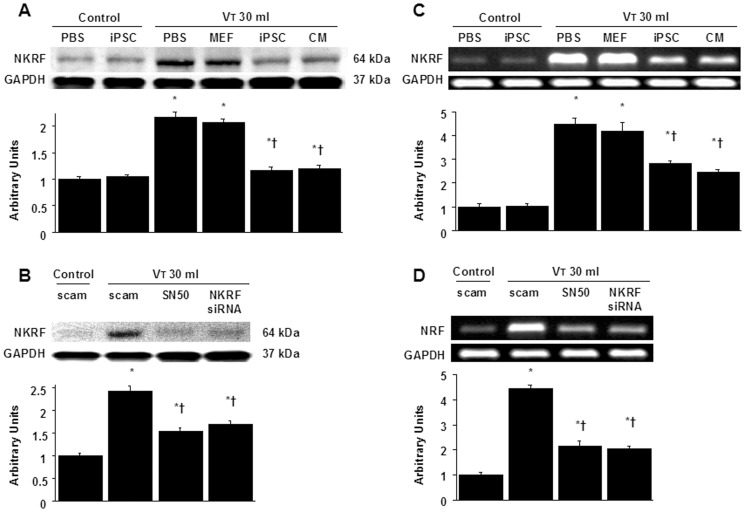
iPSCs or iPSC-CM, SN50, or NKRF siRNA abrogated lung stretch-induced NKRF and NKRF mRNA expression.NKRF expression from the lungs of VT30-ventilated wild-type mice receiving iPSCs, iPSC-CM, SN50, or NKRF siRNA was detected by Western blot analyses (A, B). The effects of administering of iPSCs, iPSC-CM, SN50, or NKRF siRNA on the mRNA expression of NKRF (C, D) are demonstrated. Data shown here are representative results of five independent experiments. Arbitrary units were expressed as the ratio of NKRF to GAPDH or NKRF mRNA to GAPDH. Data shown here are the mean ± SD of five independent experiments. *P<0.05 vs. Non-ventilated control treated with PBS or scam, †P<0.05 vs. VT30-ventilated mice treated with scam, PBS, or MEF.